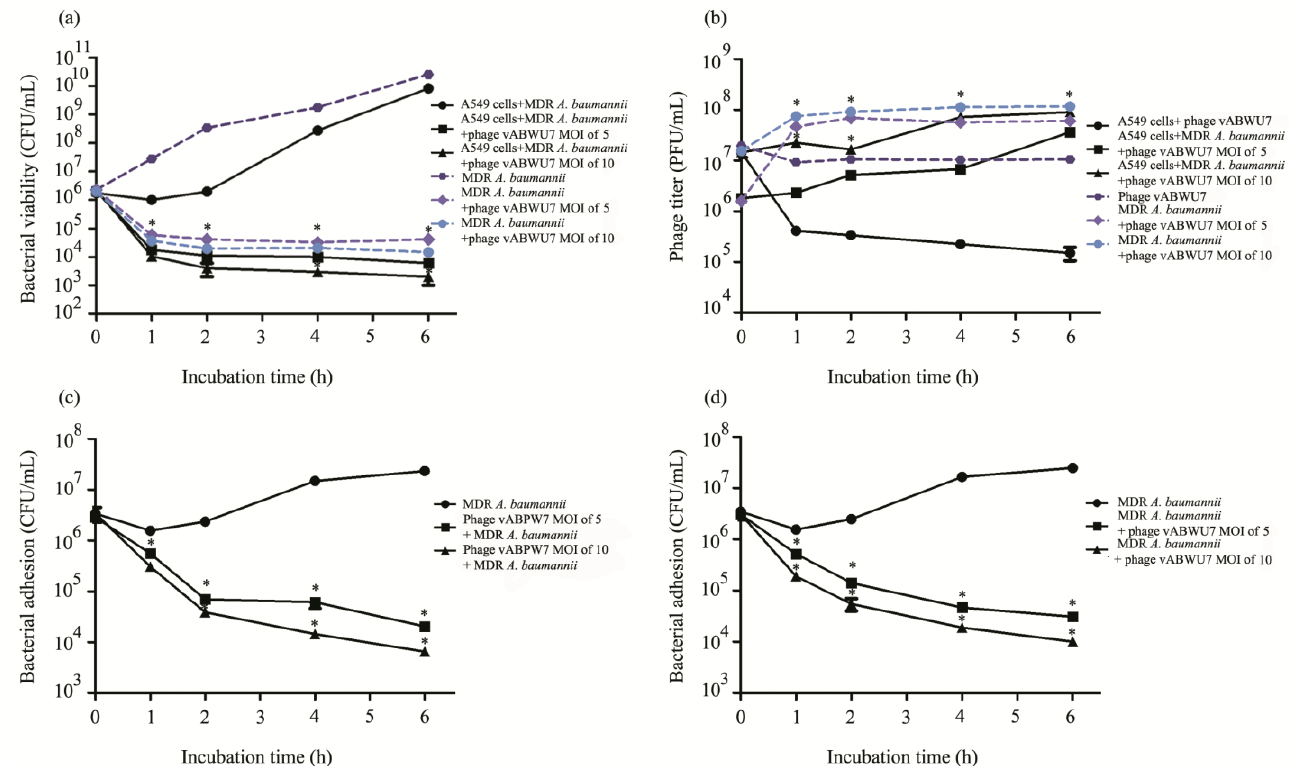
Figure 8. Efficacy of phage vABPW7 to reduce the number of planktonic and adhered MDR A. baumannii on A549 cells. Kinetics of the antibacterial activity of phage vABWU7 on planktonic bacteria under the cell culture model ( a ) was determined in parallel with the production of phage vABWU7 ( b ). The ability of phage vABWU7 to reduce bacterial attachment to the surface of A549 cells was investigated. For a prophylactic model, A549 cells were treated with phage vABWU7 and then infected with MDR A. baumannii. The number of adherent bacteria was assessed at the times indicated ( c ). For a therapeutic model, A549 cells were infected with MDR A. baumannii and then treated with phage vABWU7 . The number of adherent bacteria was assessed at the times indicated ( d ).